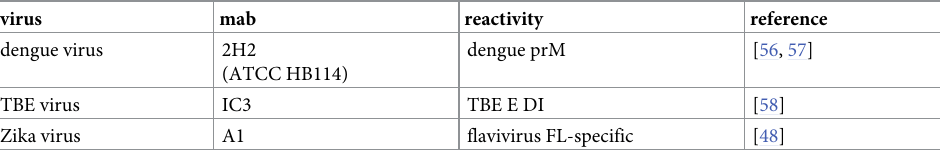
Table 2. Monoclonal antibodies used as detectors in